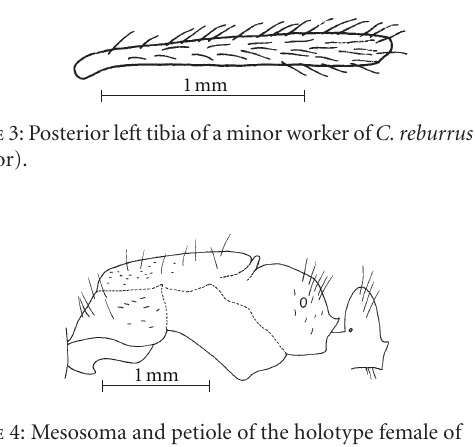
Figure 4: Mesosoma and petiole of the holotype female of C. reburrus .